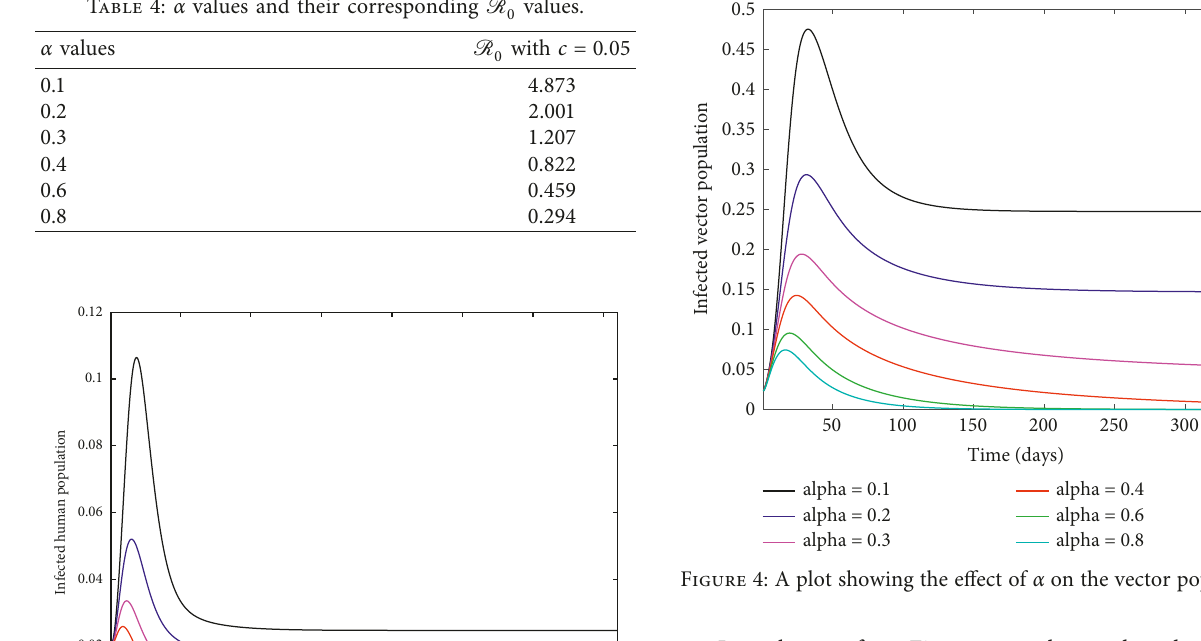
Table 4: α values and their corresponding R